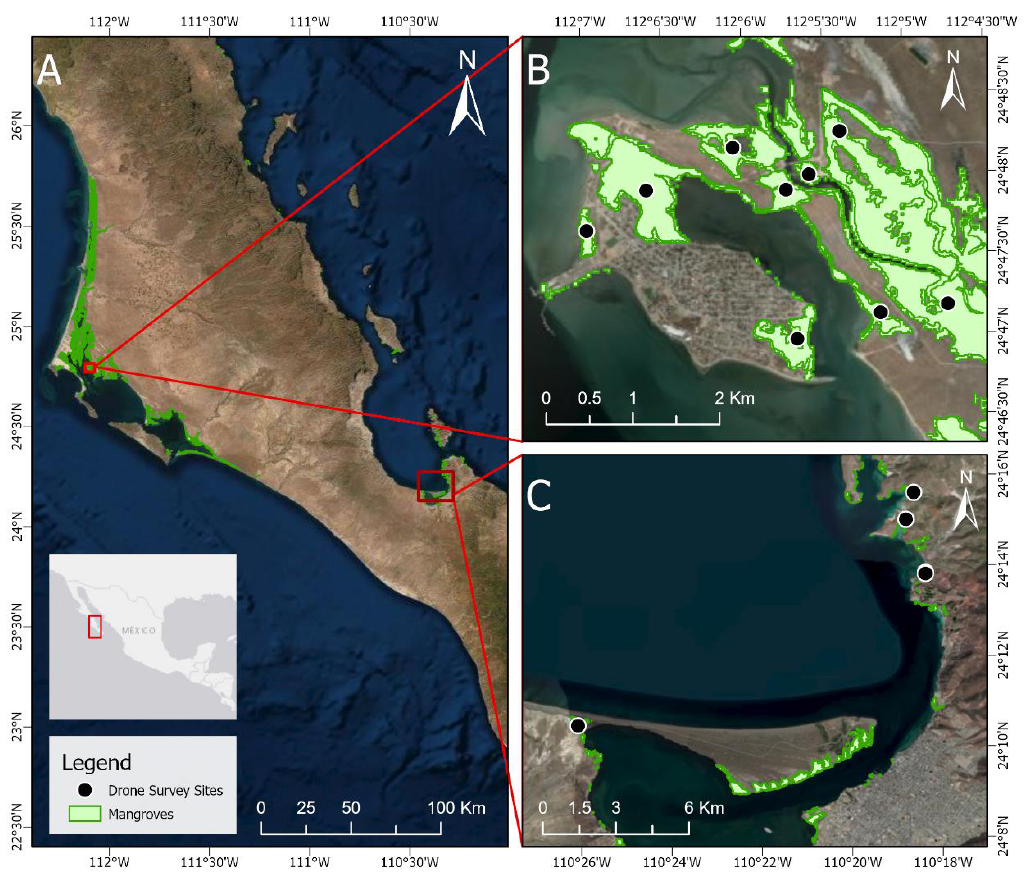
Figure 1. The study area, Baja California Sur ( A ), including Puerto San Carlos ( B ) and La Paz ( C ), for a total of 14 study sites. Note that, in La Paz, there are two sites very close together in which the circles appear overlapped.